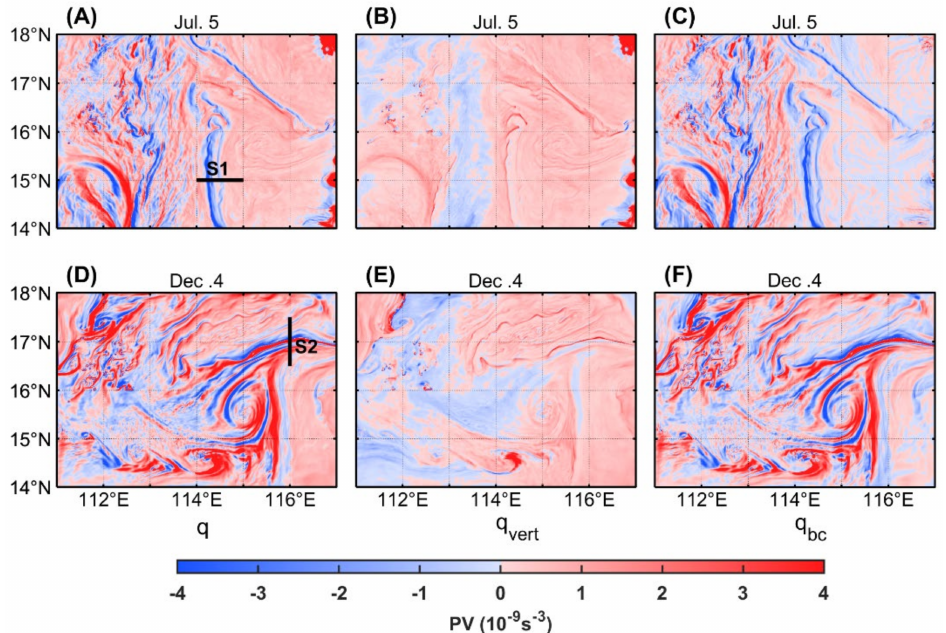
Figure 7. Comparison of the near-surface (at 5 m water depth) Ertel PV q and its sub-components in different cases. The upper (lower) row shows snapshots on 5 July (4 December). ( A ) the Ertel PV q , ( B ) the vertical component and ( C ) the baroclinic component on 5 July. ( D ) the Ertel PV q , ( E ) the vertical component and ( F ) the baroclinic component on 4 December. Two sections (S1) in the summertime and (S2) in the wintertime are selected for analyzing the vertical distribution of Ertel PV. PV, potential